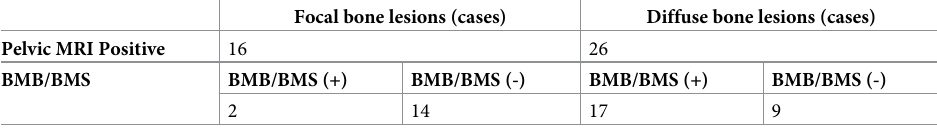
Table 5. Pelvic MRI-positive focal and diffuse bone lesions stratified by BMB/BMS results. Focal bone lesions (cases) Diffuse bone lesions